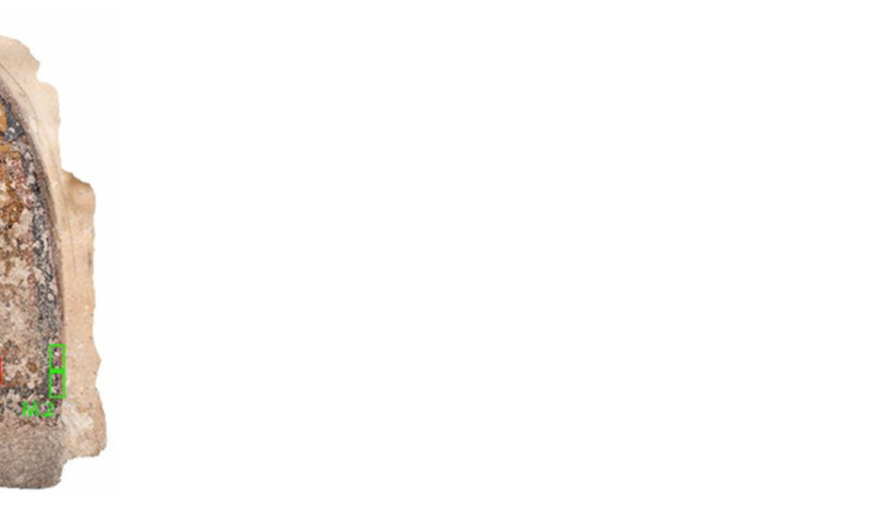
Figure 2. Conductivity measurements: two investigated areas of paintings in situ (M1 and M2 sample areas).